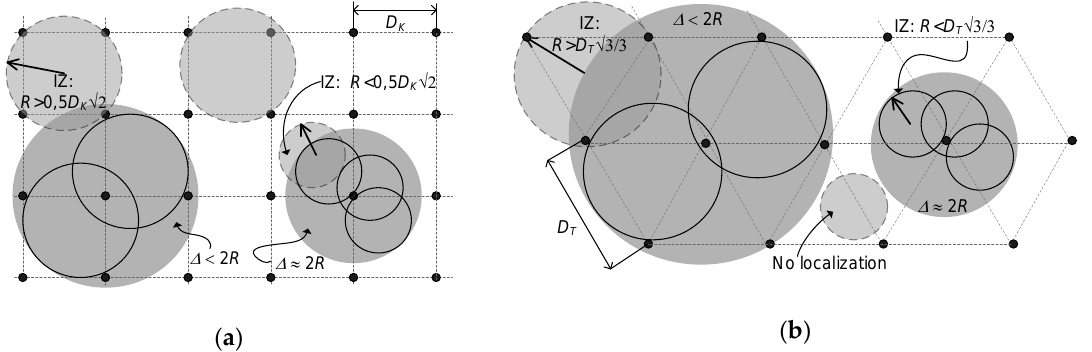
Figure 30. Considered distributions of RFID transponders/sensors: ( a ) Square network; ( b ) Triangle network. D K , D T —network constant for square and triangle meshes, respectively; ∆ —localization area; R —radius of IZ; • —RFID tag, node of network.